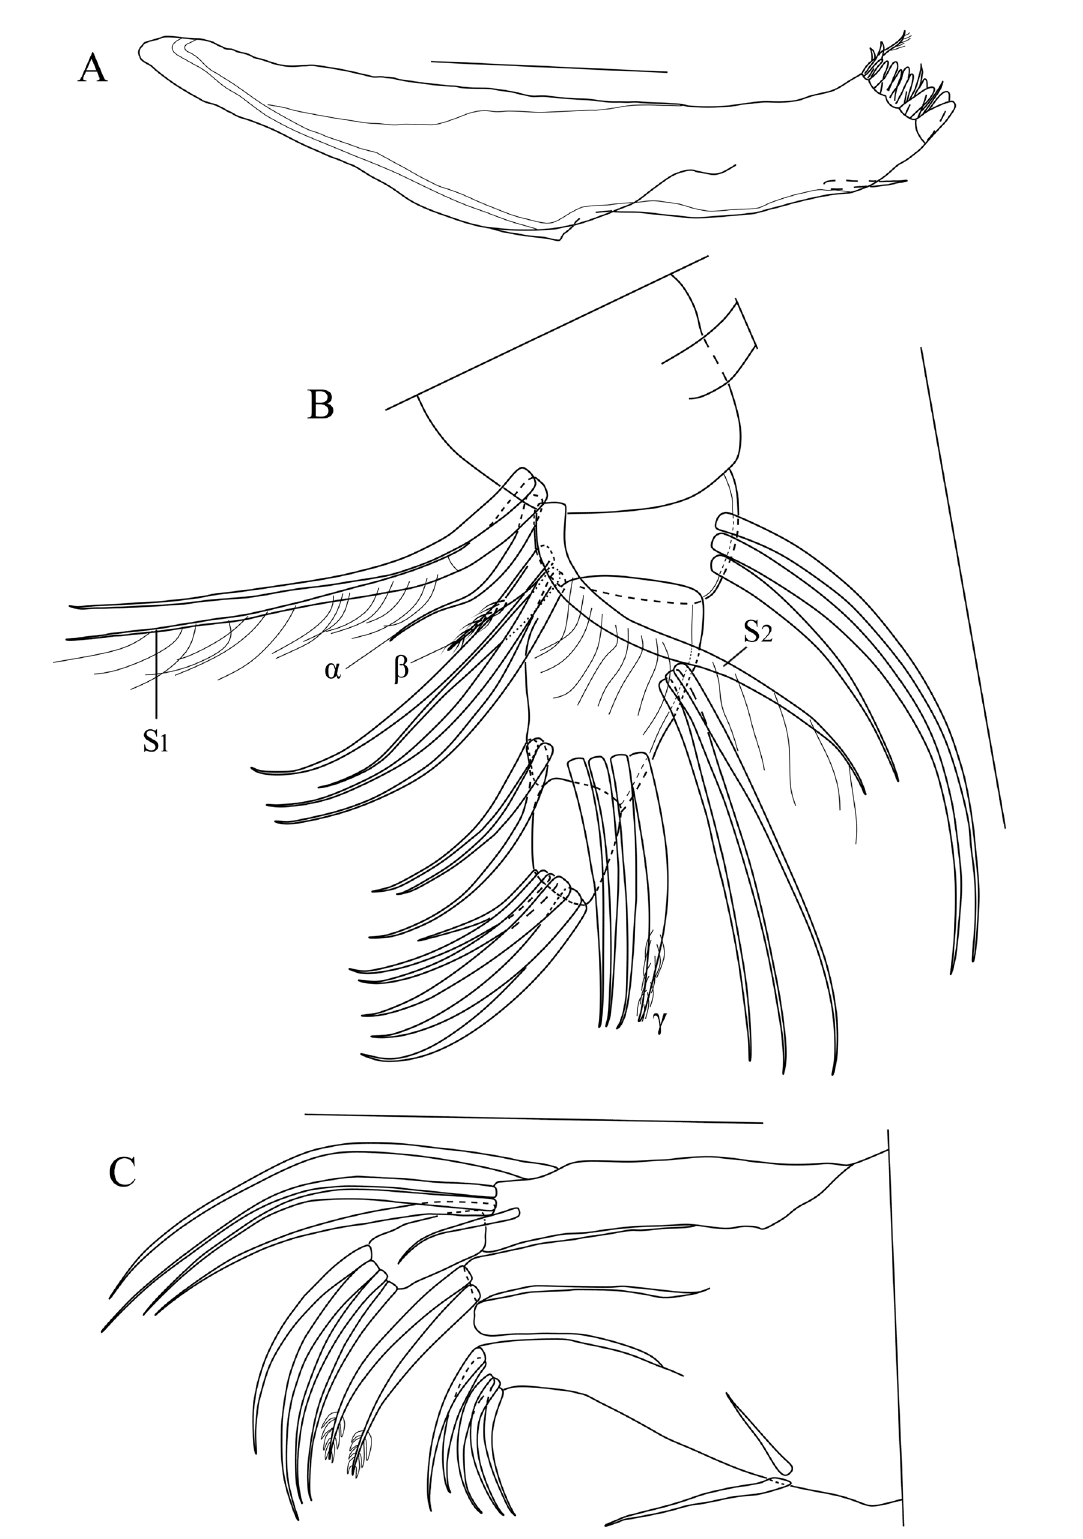
Fig. 5. Brasilodopsis baiabonita gen. et sp. nov. from Bonito, State of Mato Grosso do Sul, ♂. A . Md (MZUSP 41827). B . Md-palp (MZUSP 41825). C . Mx1 (MZUSP 41825). Abbreviations: see text and Material and methods. Scale bars: A–C = 50